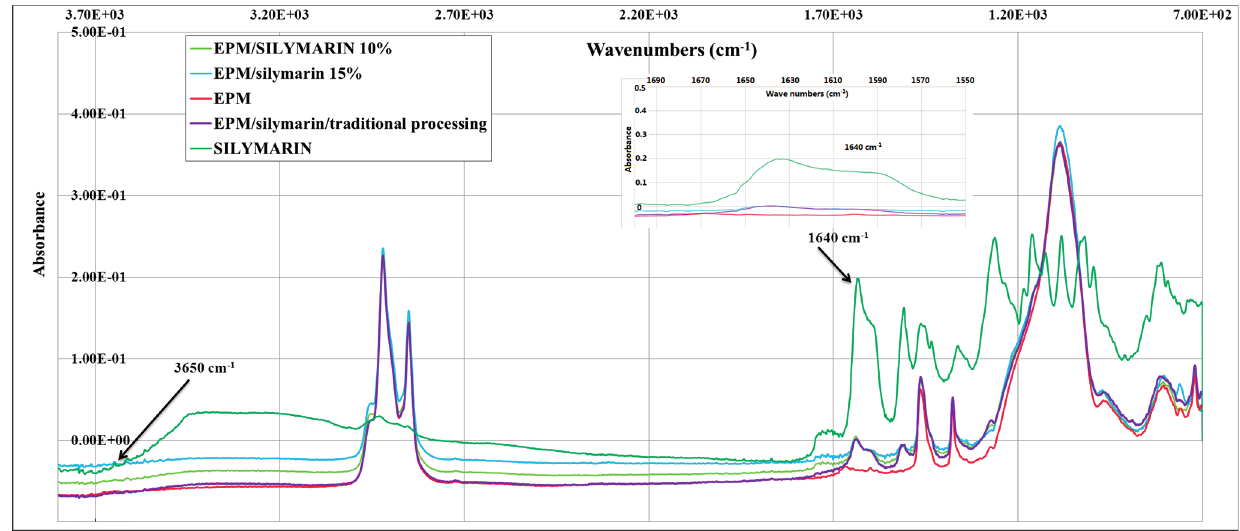
Figure 2. FTIR spectra for EPM stabilized with silymarin.